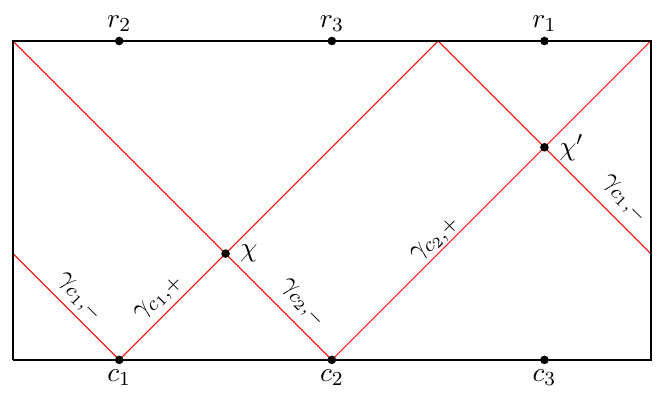
Figure 7. Illustration of lemma 9, shown for the case n = 3